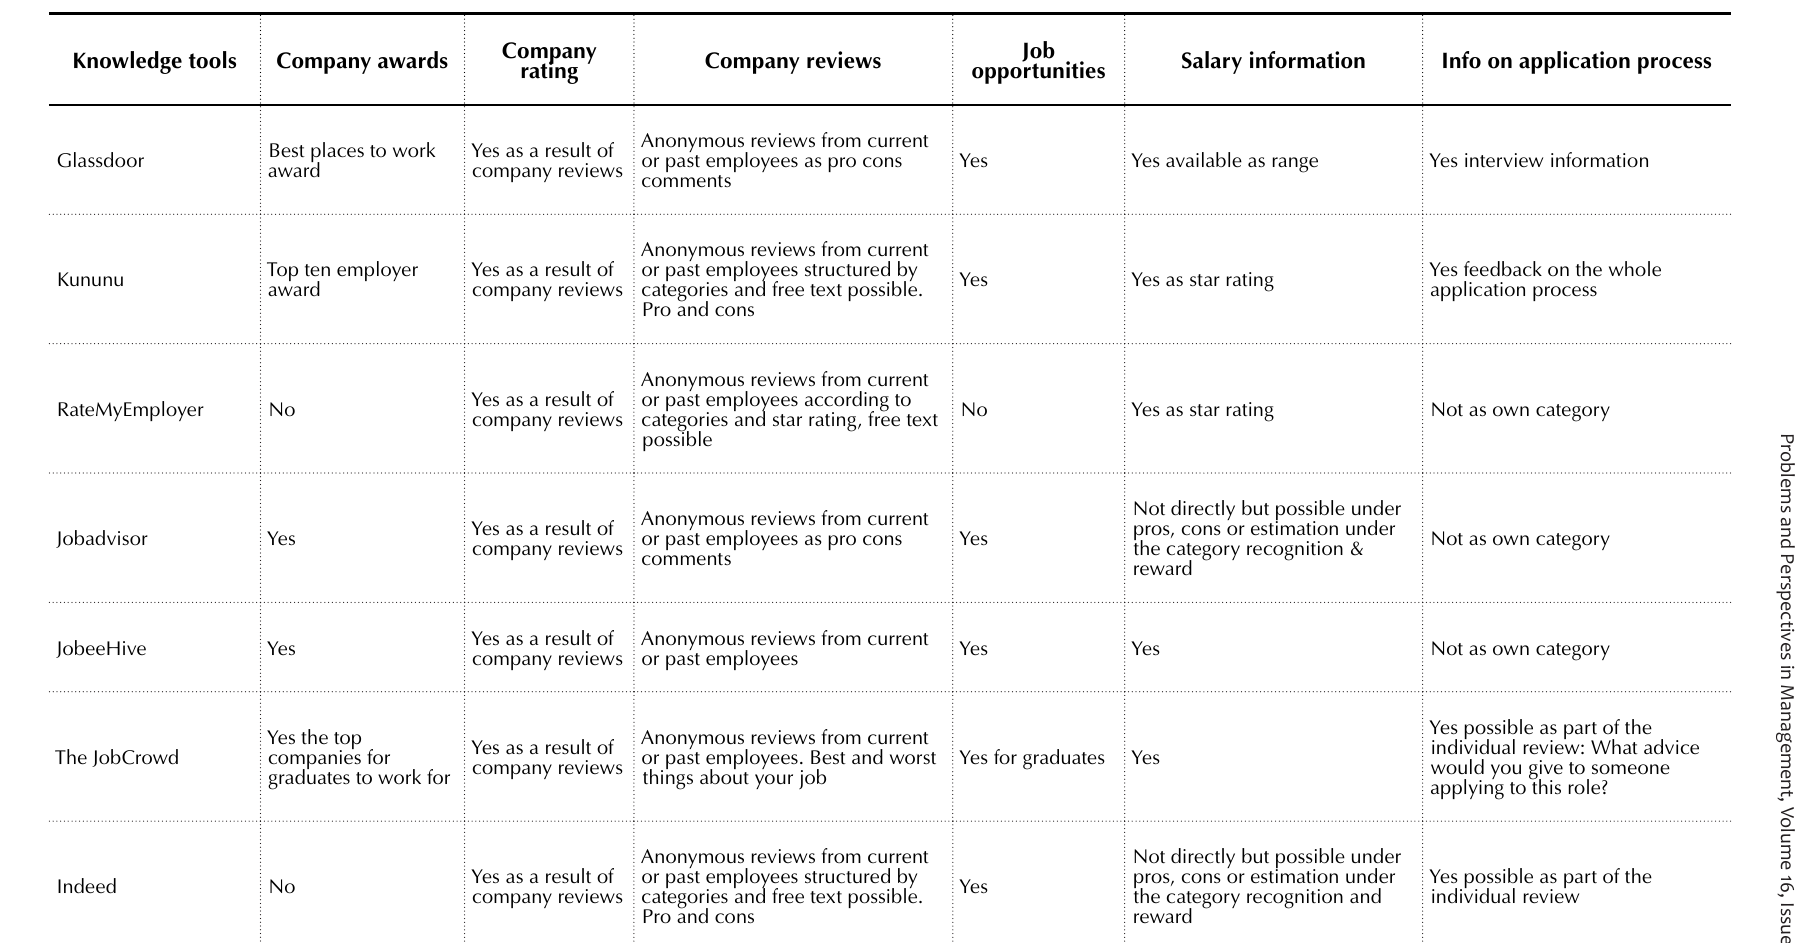
Table 2. Content of Job Review Sites Knowledge